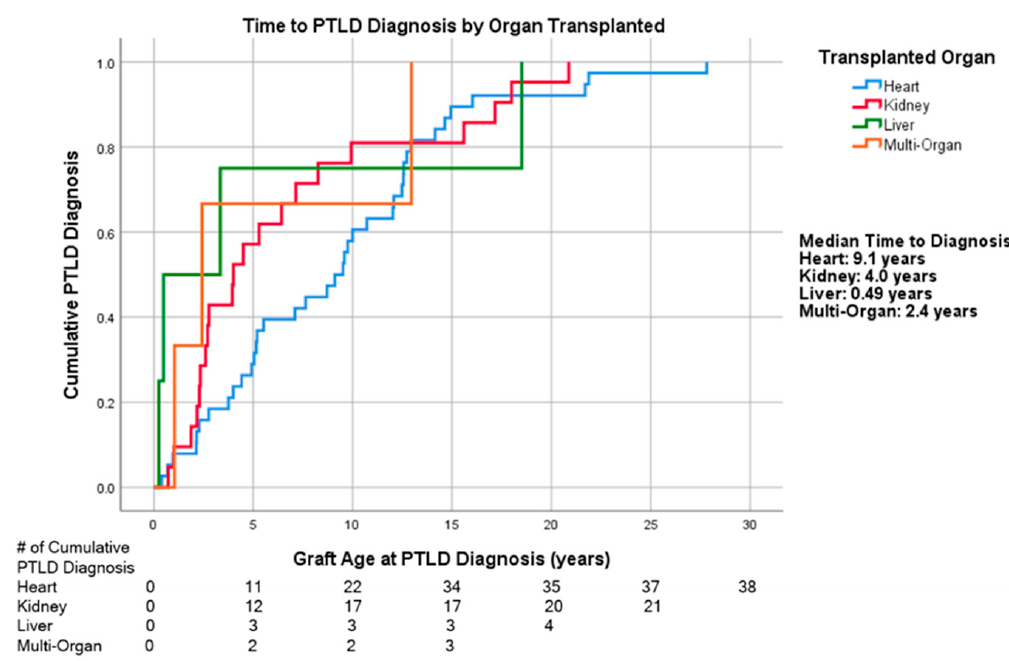
Figure 1. ( A ). Cumulative PTLD diagnosis categorized by age group. ( B ). Cumulative PTLD diagnosis categorized by transplanted organ.